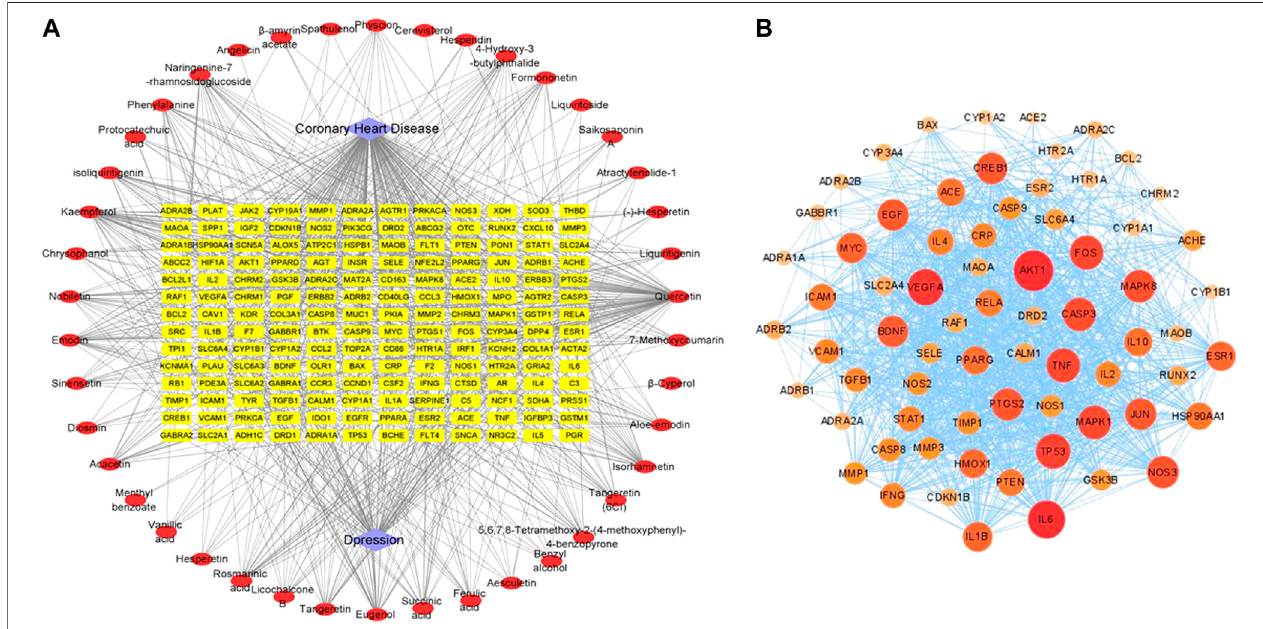
FIGURE 3 | The networks associating with XPF in the treatment of CHD with depression. (A) The component-target network consisted of 42 components, 168 targets and 2 diseases including 212 nodes and 845 edges. (B) The PPI network of hub targets obtained from STRING database and constructed by